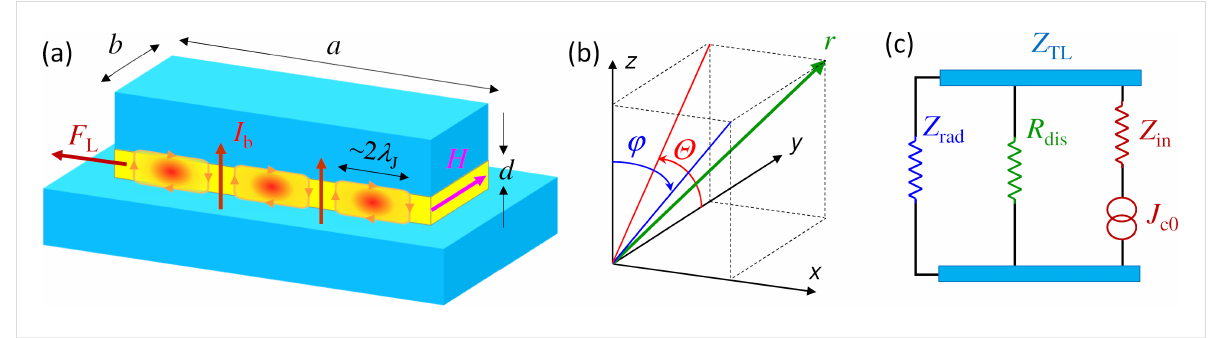
Figure 1: (a) A sketch of the Josephson flux-flow oscillator. It is based on a sandwich-type junction with two superconducting electrodes (light blue) separated by a dielectric interlayer (yellow). Red ovals represent Josephson vortices that are driven by the Lorentz force, F L , exerted by the dc bias current, I b . From the outside, the junction has a patch antenna geometry. However, inside it is driven by a distributed dc current, and the oscillating voltage is generated internally by a combination of the ac-Josephson effect and the flux-flow phenomenon. (b) Clarification of spatial and angular co- ordinates. (c) An equivalent circuit of the Josephson junction. The ac-Josephson effect provides a source of the high-frequency alternating current with the fixed amplitude of current density, J c0 . The oscillating voltage at the junction edges is generated by means of the input junction impedance, Z in , and is distributed between the internal dissipative resistance, R dis , and the external radiative impedence, Z rad , connected by the transmission line impedance Z TL